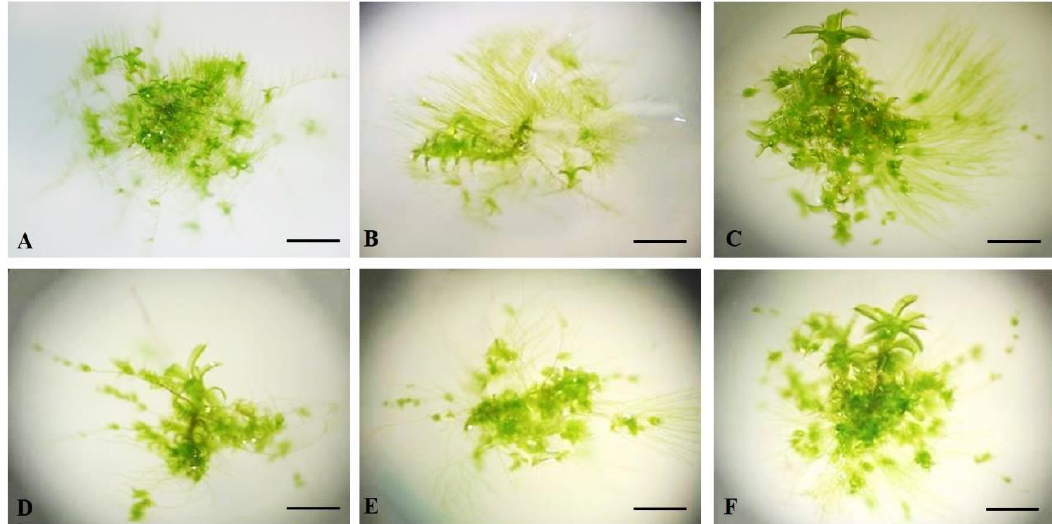
Figure 4. The appearance of Pterygoneurum sibiricum explants grown on KNOP nutrient medium supplemented with IBA and BAP in Experiment type II: ( A ) PGR-free; ( B ) 0.1 µM IBA; ( C ) 0.1 µM BAP; ( D ) 0.03 µM IBA + 0.1 µM BAP; ( E ) 0.1 µM IBA + 0.1 µM BAP; ( F ) 0.3 µM IBA + 0.1 µM BAP. The bars represent size (( A – F ) 4 mm).